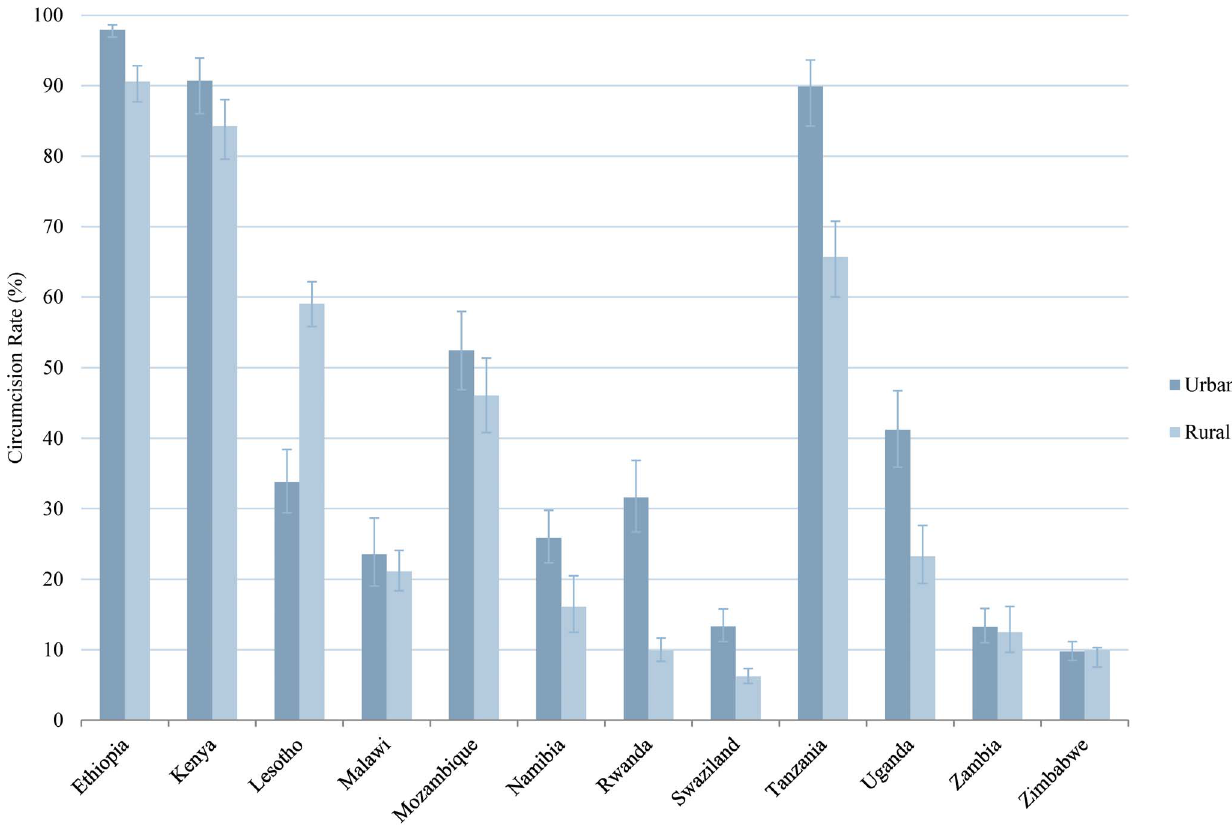
Figure 5. Male Circumcision Rates in Eastern and Southern African Countries, by Residence. Percent circumcised among males by place of residence: urban or rural. Error bars represent 95% CI.